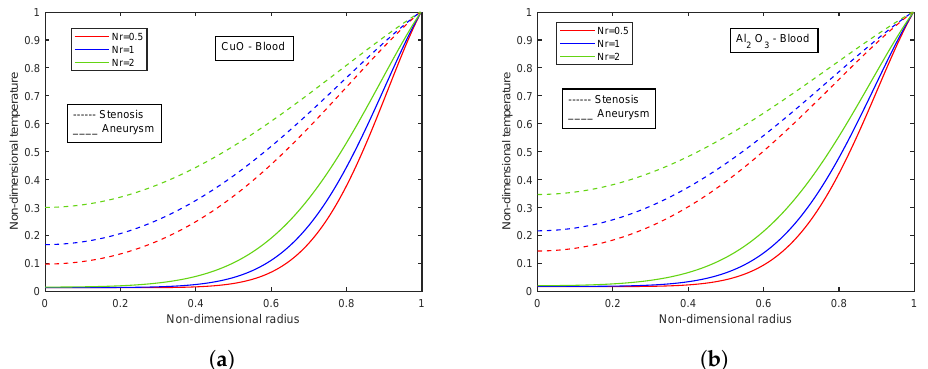
Figure 29. Influence of radiation parameter Nr on temperature profiles for ( a ) CuO-nanoparticles, ( b ) Al 2 O 3